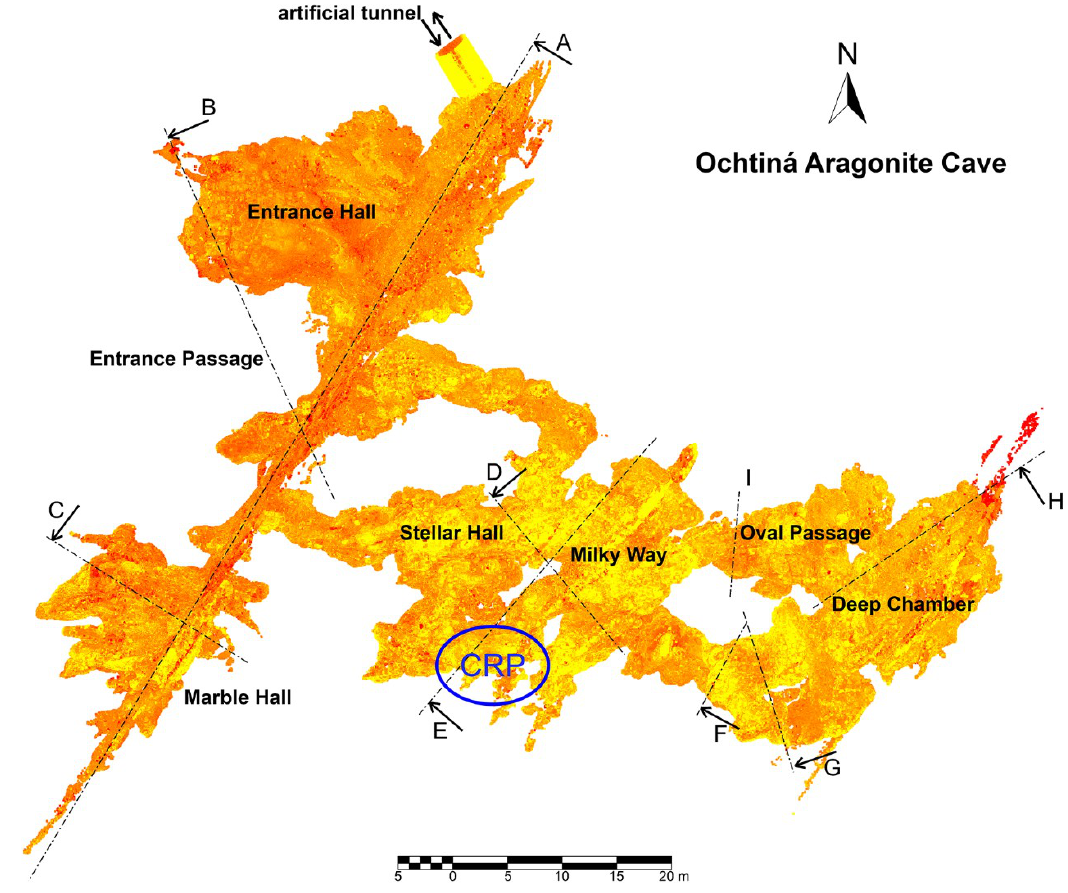
Figure 6. Top view of the final point cloud with a position of cross-sections through the point cloud and site of the survey realized by digital close-range photogrammetry (DCRP).